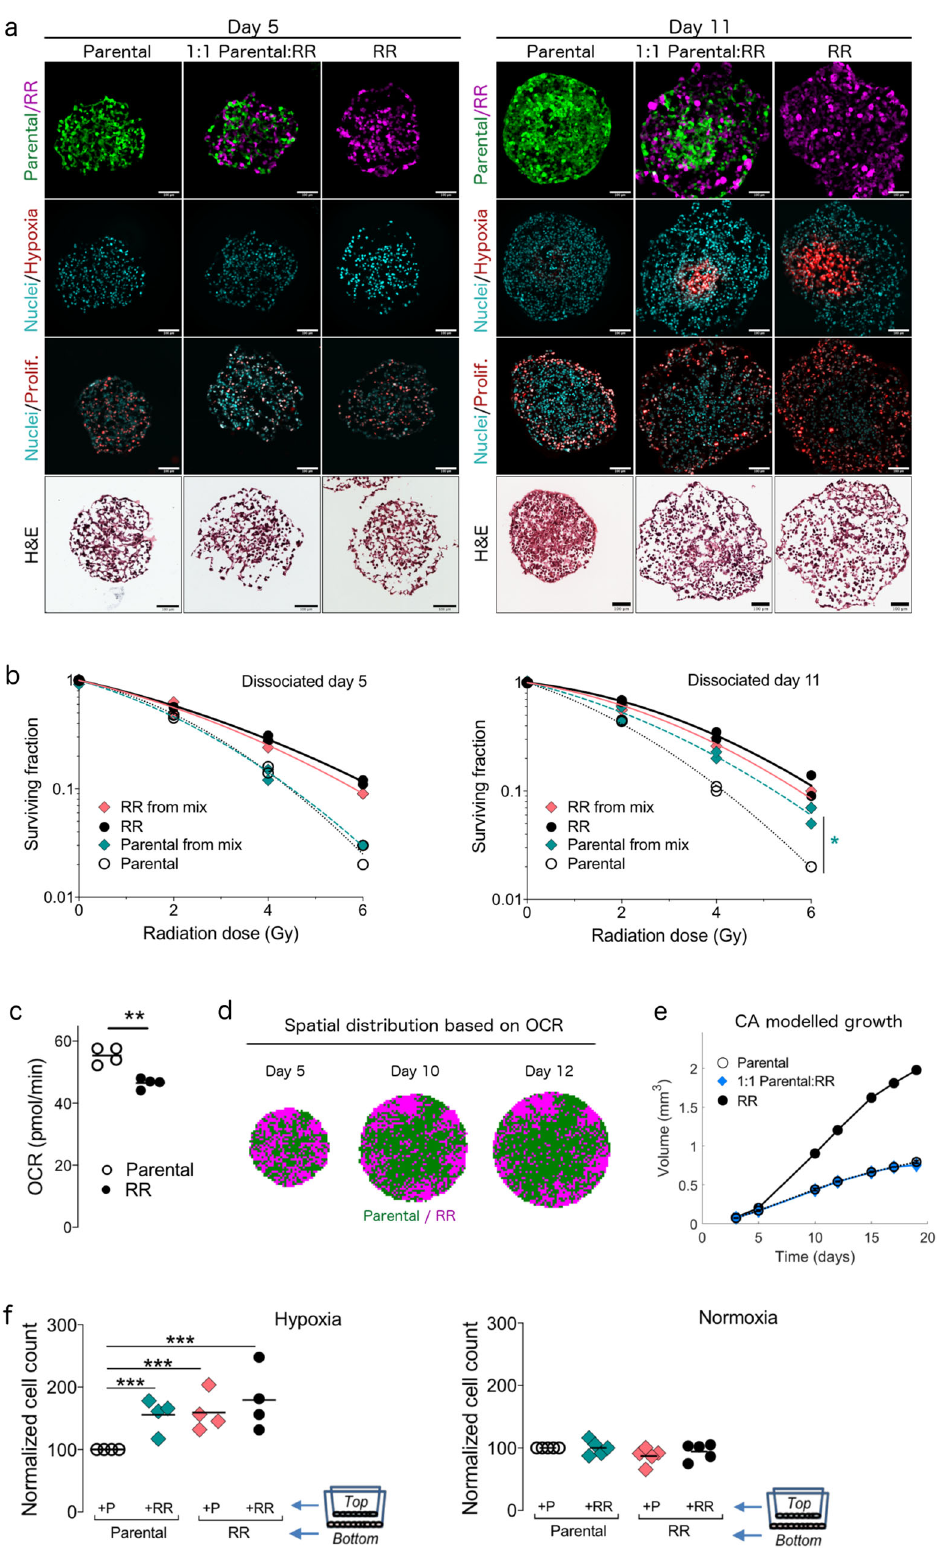
radioresistant cells located in the periphery could metastasise 16 , while parental cells in hypoxia would have reduced sensitivity to radiation. Since the ef fi cacy of radiotherapy may also depend on the spatial distribution of tumour populations, these results suggest that spatially-explicit mathematical models may be nee- ded to further optimise radiation treatments. For example, the